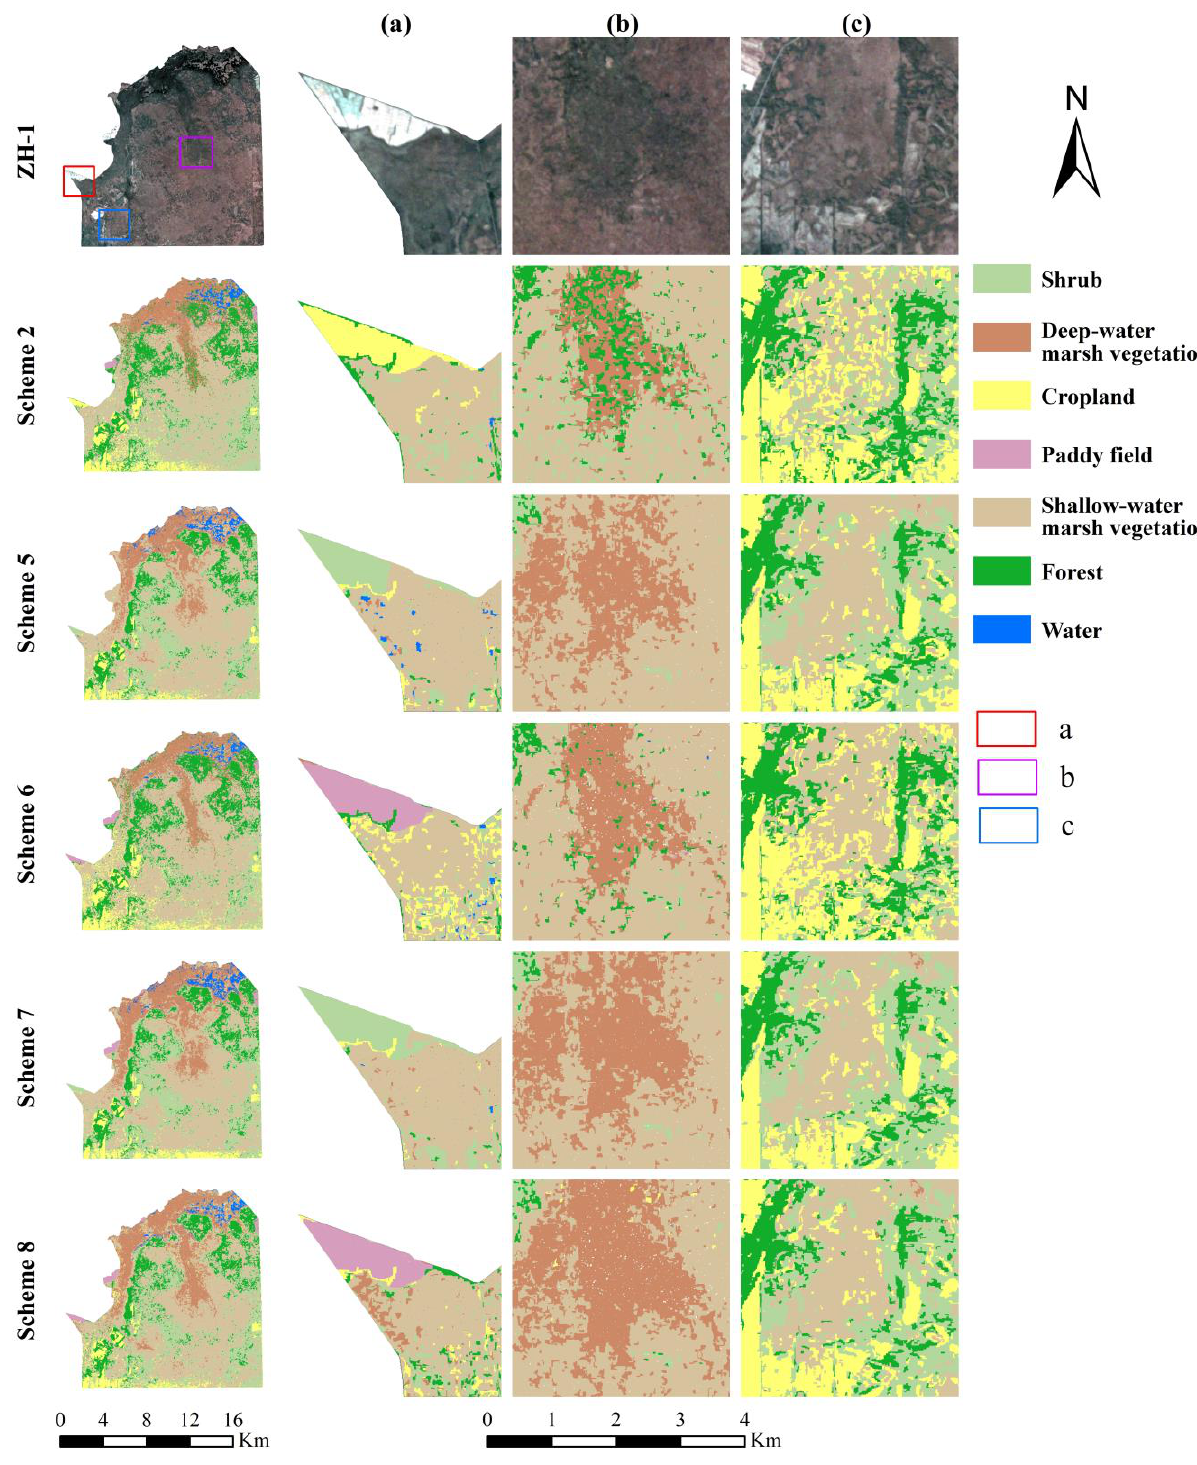
Figure 4. Classification results of different schemes using the optimal models. ( a ) Paddy filed; ( b ) Deep-water marsh vegetation; ( c ) Shallow-water marsh vegetation and cropland.